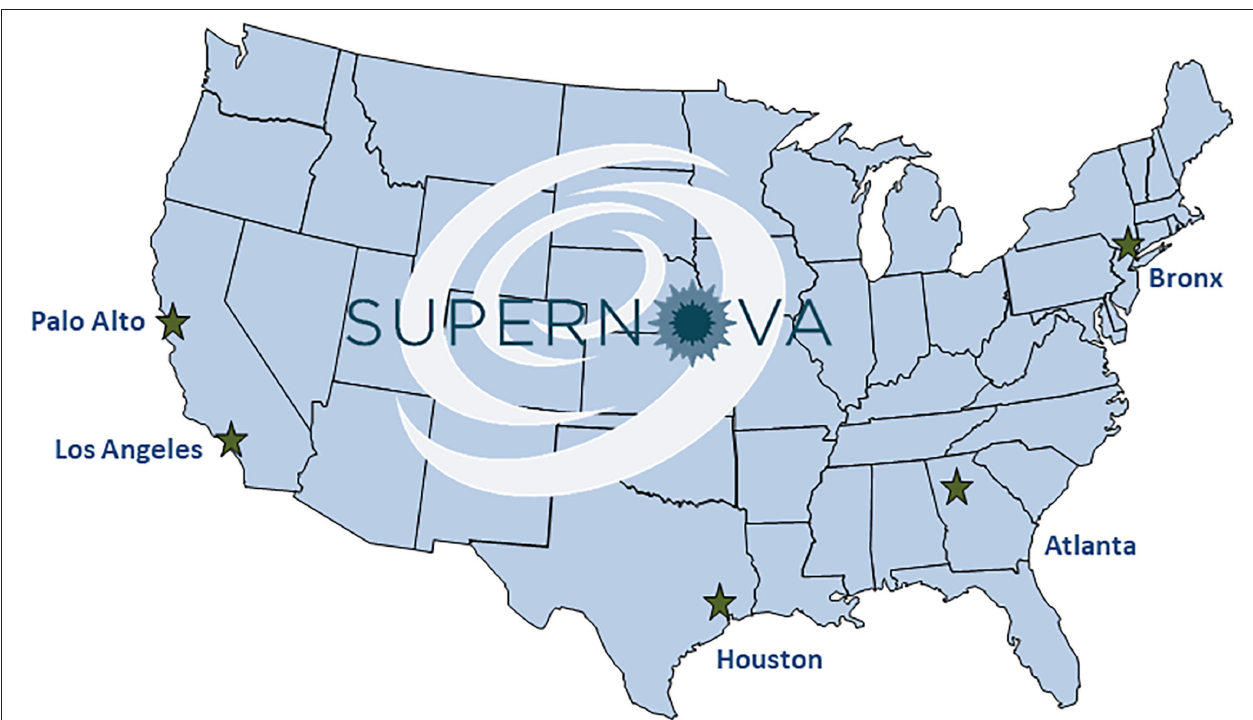
FIGURE 1 | Map of five sentinel sites conducting COVID-19 surveillance—Surveillance Platform for Enteric and Respiratory Infectious Organisms at Veterans Affairs Medical Centers (SUPERNOVA), United States, 2020–2021.